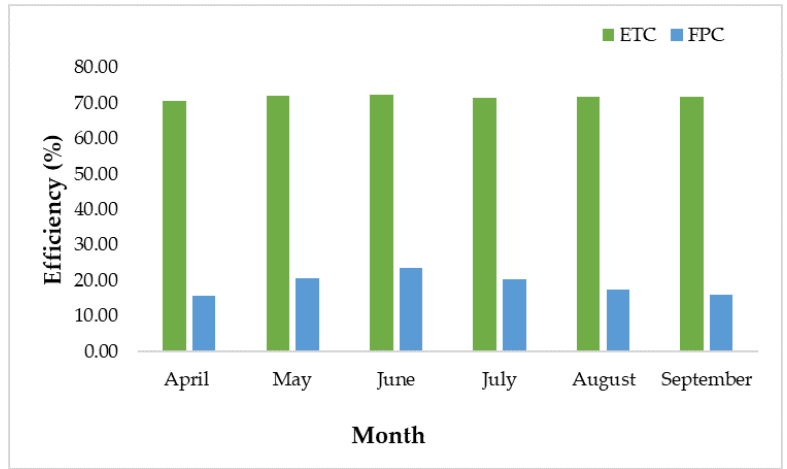
Figure 15. Monthly efficiencies of ETC and FPC for optimized flow scheme (S-3).